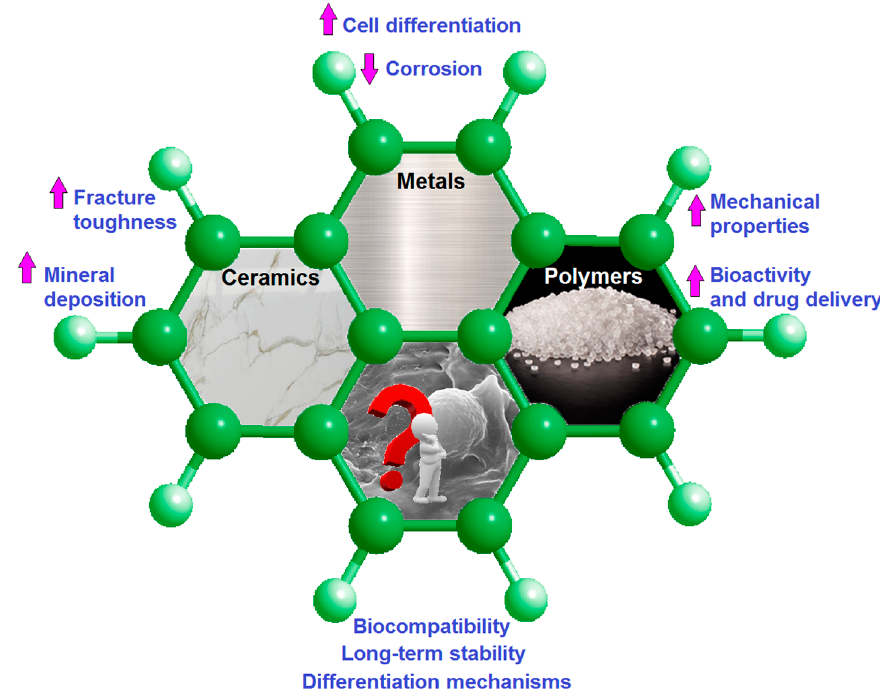
Figure 4. Potential enhancements offered by GFNs in biomaterials and essential aspects to be designed to translate the biocomposites to clinical examination.